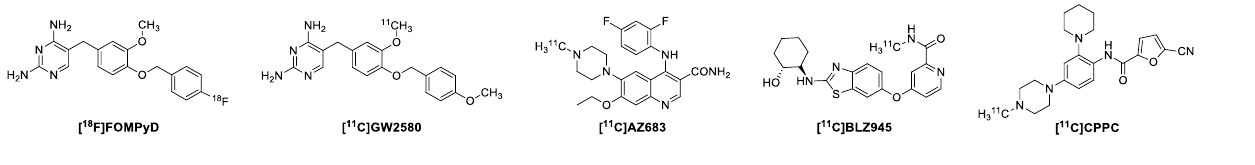
Figure 1. Known CSF1R PET radioligands.